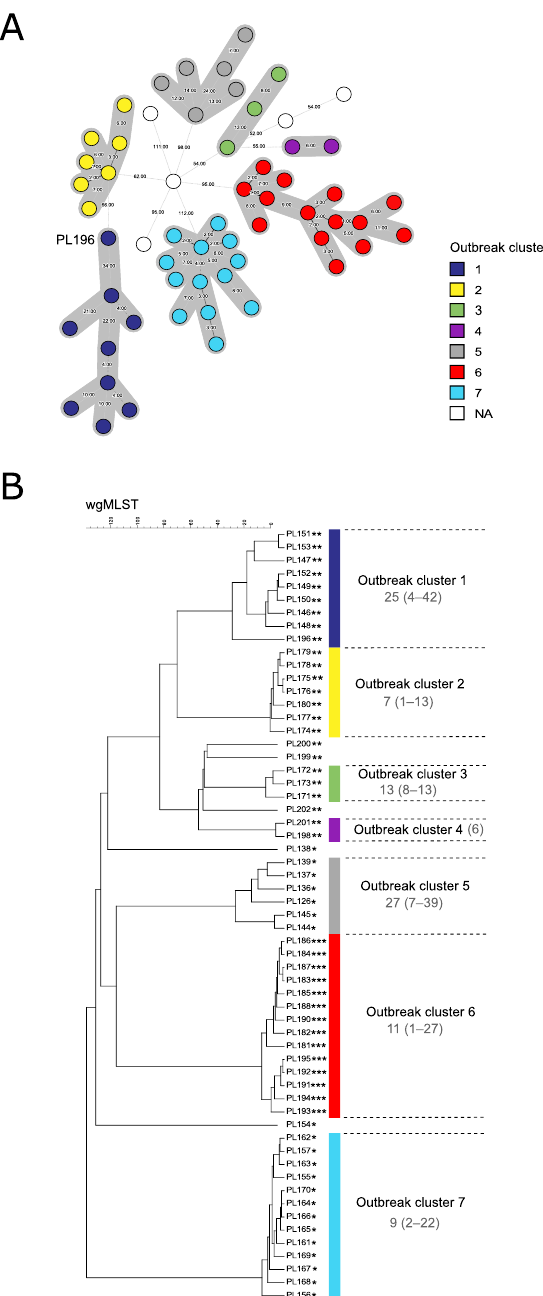
Figure 2. Whole-genome MLST analysis of 59 outbreak-related Paenibacillus larvae isolates of the ERIC I-ST2 type. Each isolate is colored according to the corresponding P. larvae outbreak cluster; the isolates without an assigned outbreak cluster are denoted “not assigned” (NA). The wgMLST analysis was based on 5738 wgMLST loci. ( A ) wgMLST minimum spanning tree. The connecting line lengths are proportional to the number of allele differences (AD) between isolates, which are denoted on the lines. Closely related isolates belonging to the same outbreak cluster ( ≤ 35 AD) are shaded in gray. Isolate PL196 is highlighted (for details, see Section 3.2.). ( B ) UPGMA wgMLST tree. Scale bar indicates the number of AD. The median pairwise AD between the isolates of the same outbreak cluster is shown on the right of the tree, with the minimum and maximum AD in parenthesis. *, isolates exhibiting a conventional ERIC I banding pattern; **, isolates exhibiting a slightly altered ERIC I pattern with an additional 600-bp band; ***, isolates exhibiting a slightly altered ERIC I pattern with an additional 650-bp band. For isolate metadata, see Table